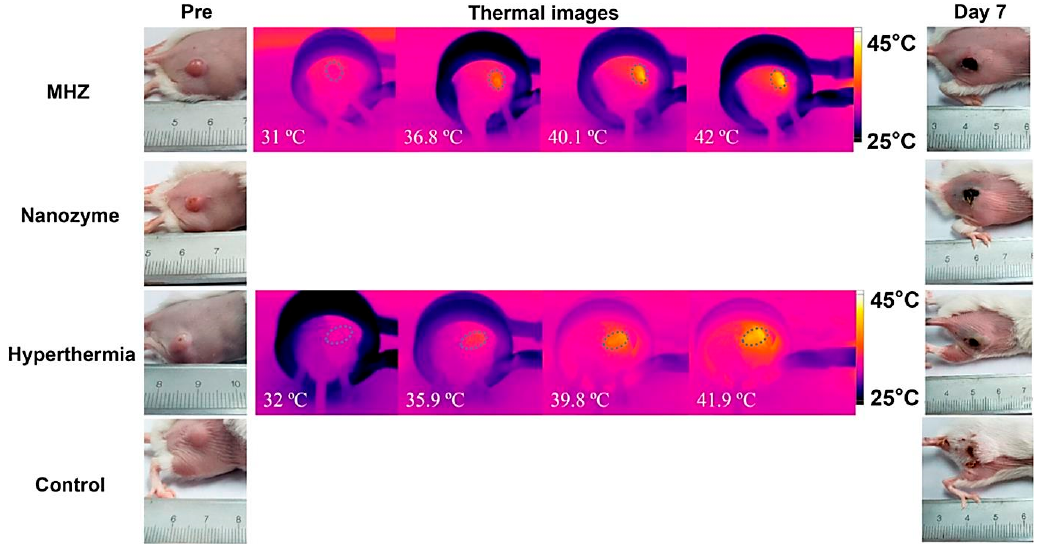
Figure 8. Tumor treatment process by hyperthermia. Here, the magnetic nanoenzyme was utilized as the target-specific material which was stimulated in the presence of an alternating magnetic field [131] © 2021 American Chemical Society.